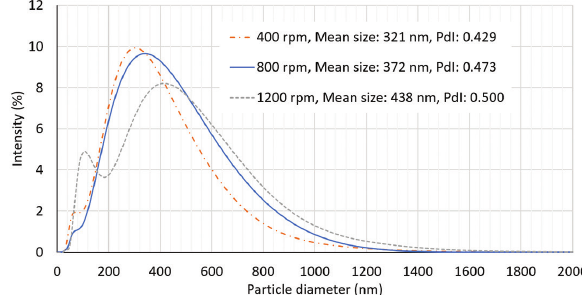
Figure 7: Effect of disc rotational speed on PSD of starch nanoparticles at 1:1 antisolvent to solvent ratio and 18 mL/s.